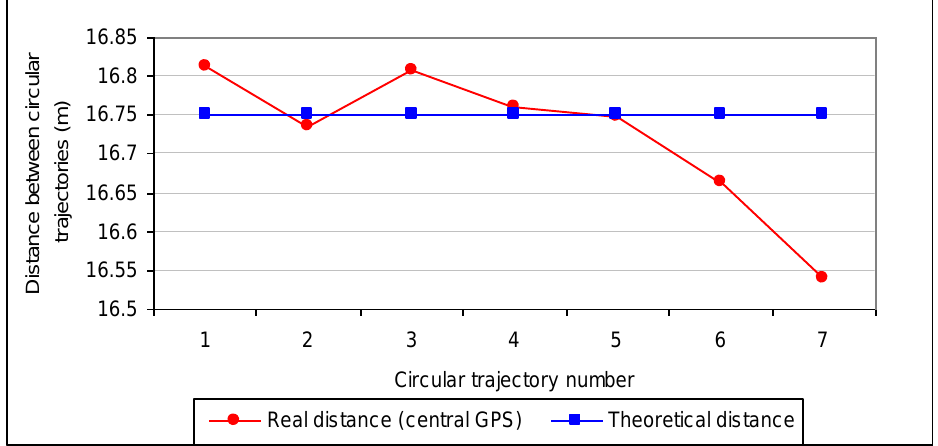
Figure 10. Real distance between concentric passes according to data from a GPS RTK located on the center of the boom in comparison to the theoretical distance programmed into the self-guidance system of the tractor equipped with a GPS John Deere Autotrac Universal.